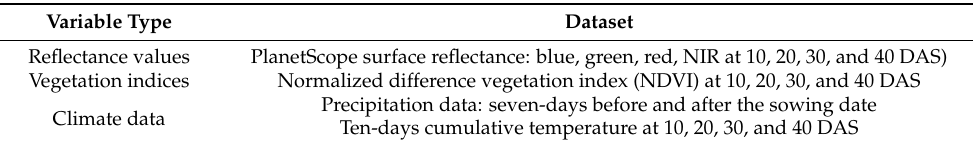
Table 2. Predictor variables used in partial least squares (PLS) and random forest (RF) regression